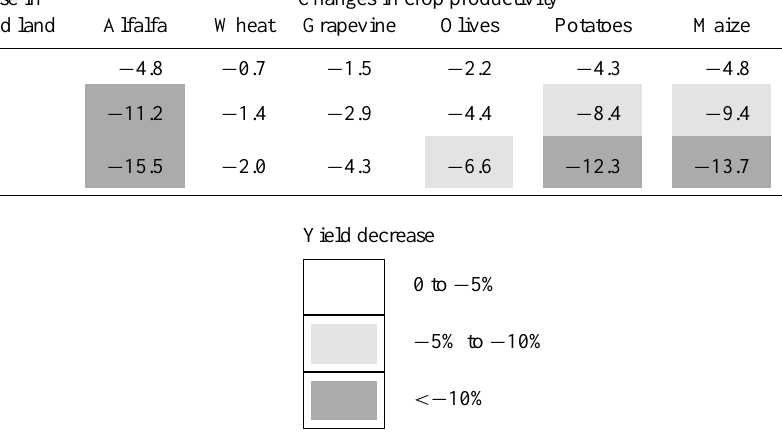
Table 8. Yield changes for irrigated area policy scenarios. Decrease in Changes in crop productivity Alfalfa Wheat Grapevine Olives Potatoes